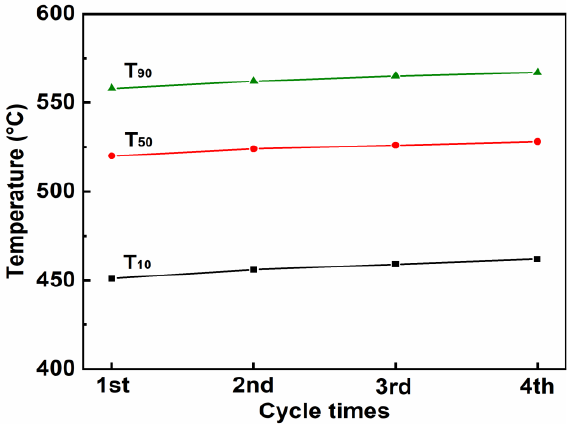
Figure 10. Stability of CuCo 2 O 4 -N catalyst in cycle tests for soot combustion. Table 6. XPS parameters of CuCo 2 O 4 -N catalyst before and after